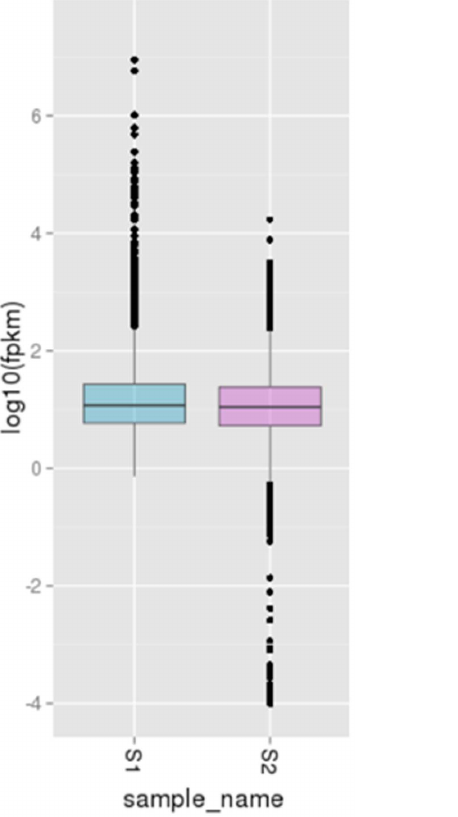
Figure 3. Boxplot of the log FPKM (Fragments Per Kilobase of exon per Million fragments mapped) expression values in both the green- (S1) and the russet-pericarp pool (S2) libraries of sand pear. The figure shows that the median of the expression values across the libraries being compared for differential expression are